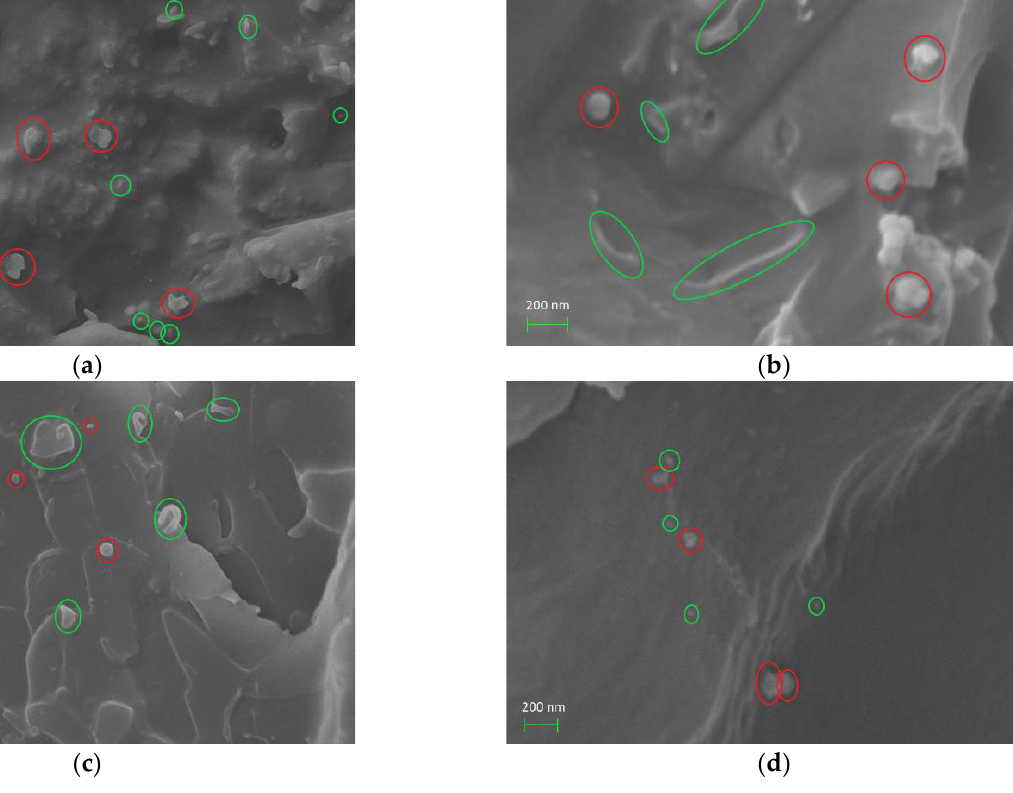
Figure 2. SEM images of the fabricated nanocomposites with 10 phr Fe 3 O 4 and 5 phr ( a ) CB; ( b ) MWCNT; ( c ) GnP; ( d ) ND concentration. Green circles denote the respective type of the carbon allotrope, while red circles indicate the Fe 3 O 4 nanoparticles.